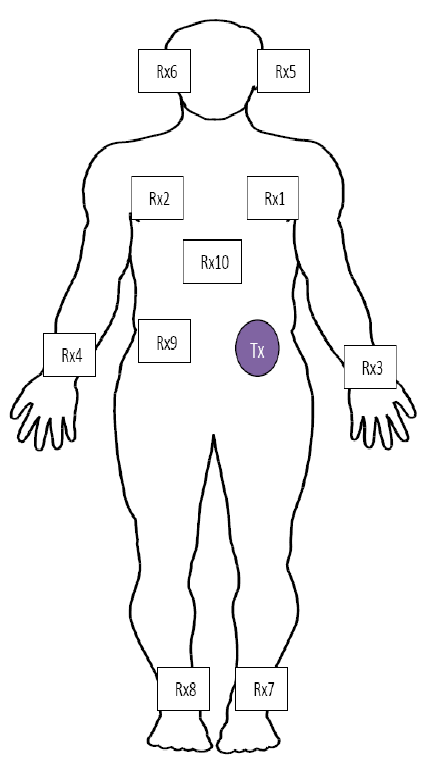
Figure 11. On-body radio propagation channel characterization measurement settings at 2.45 GHz showing the transmitter antenna is on the left waist while the receiver antenna is attached to 10 different locations on the